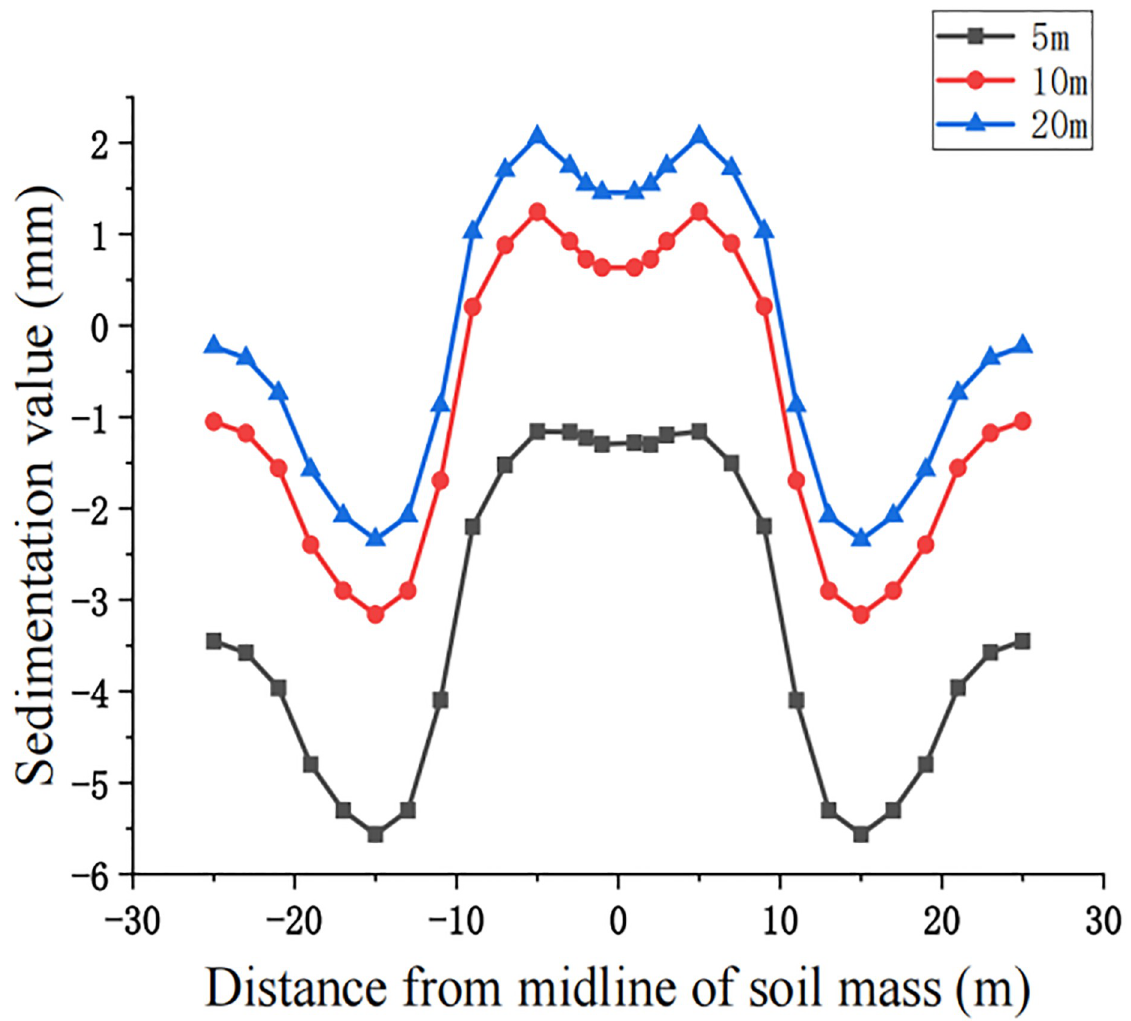
Fig 15. Surface deformation curves for three working conditions of